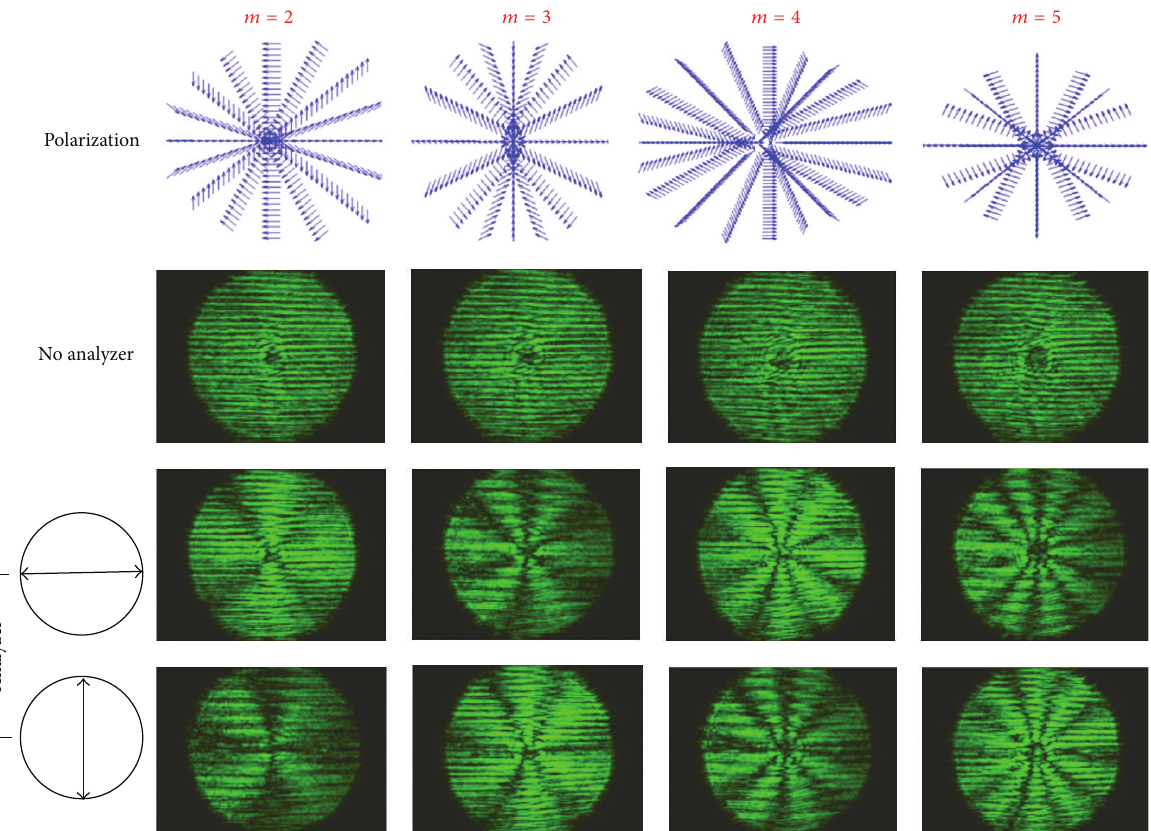
Figure3:Cylindricalvectorbeamsgeneratedwithintegertopologicalchargesfrom 𝑚 = 1 to5,allbeamsaregeneratedwiththesameconstant phase difference 𝜓 = 0